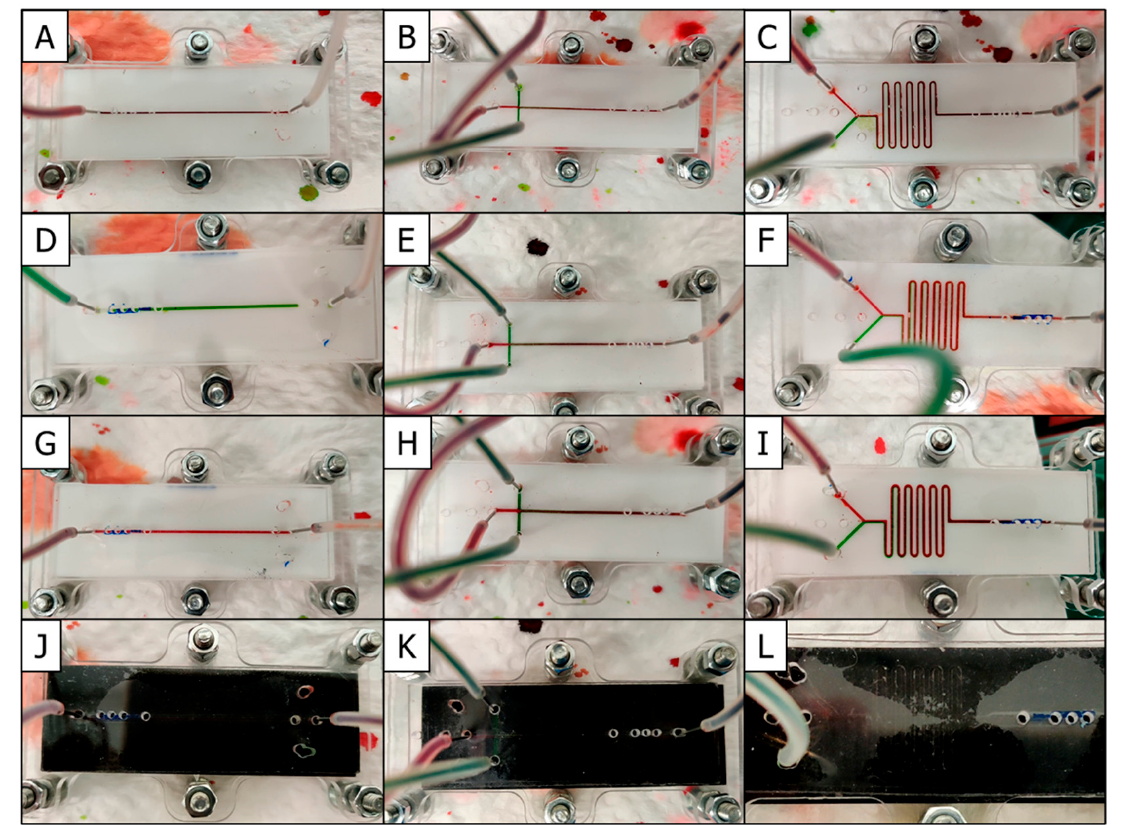
Figure 4. Photographs of microfluidics devices from various fabrication methods and designs being tested under colored liquid flow at 50 μ L/min. ( A ) M ‐ 3D FDM with single straight channel, ( B ) M ‐ 3D FDM with crossed junction, ( C ) M ‐ 3D FDM with mixer channel, ( D ) D ‐ CNC with single straight channel, ( E ) D ‐ CNC with crossed junction, ( F ) D ‐ CNC with mixer channel, ( G ) M ‐ CNC with single straight channel, ( H ) M ‐ CNC with crossed junction, ( I ) M ‐ CNC with mixer channel, ( J ) Laser Chip with single straight channel, ( K ) Laser Chip with crossed junction, and ( L ) Laser Chip with mixer channel.